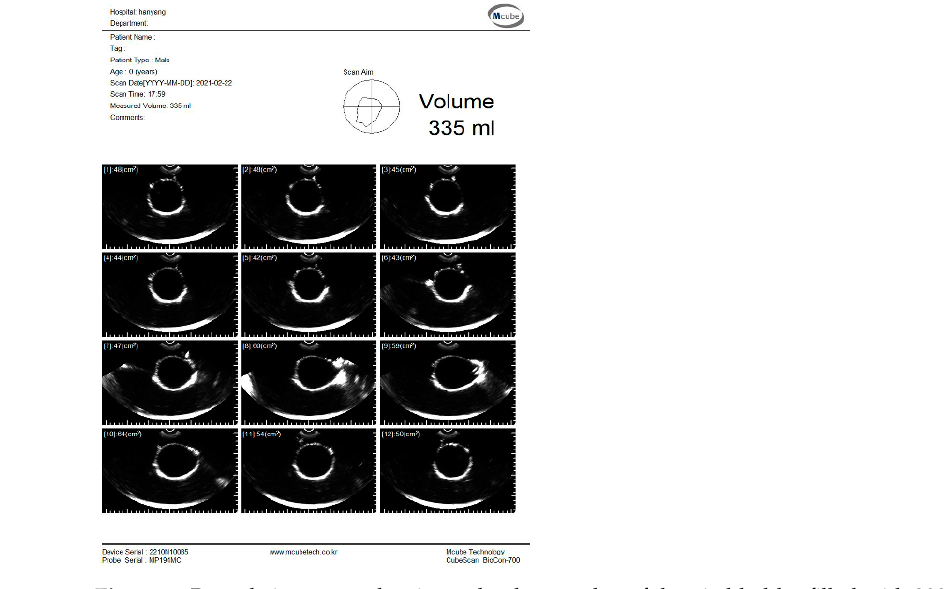
Figure 8. B-mode images and estimated volume value of the pig bladder filled with 300 mL of water.